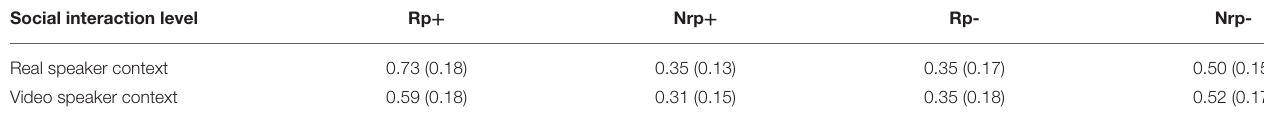
TABLE 2 | The correct recall rate of listeners on item types under different experimental conditions. Social interaction level Rp